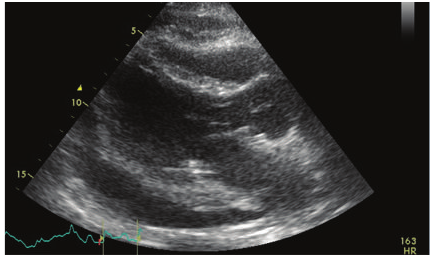
Figure 4: Echocardiographic image showing collapsed right ventri- cle with